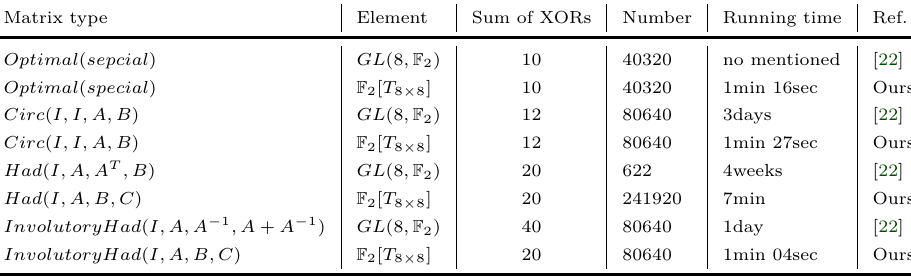
Table 6: Comparisons of construction efficiency with [22]